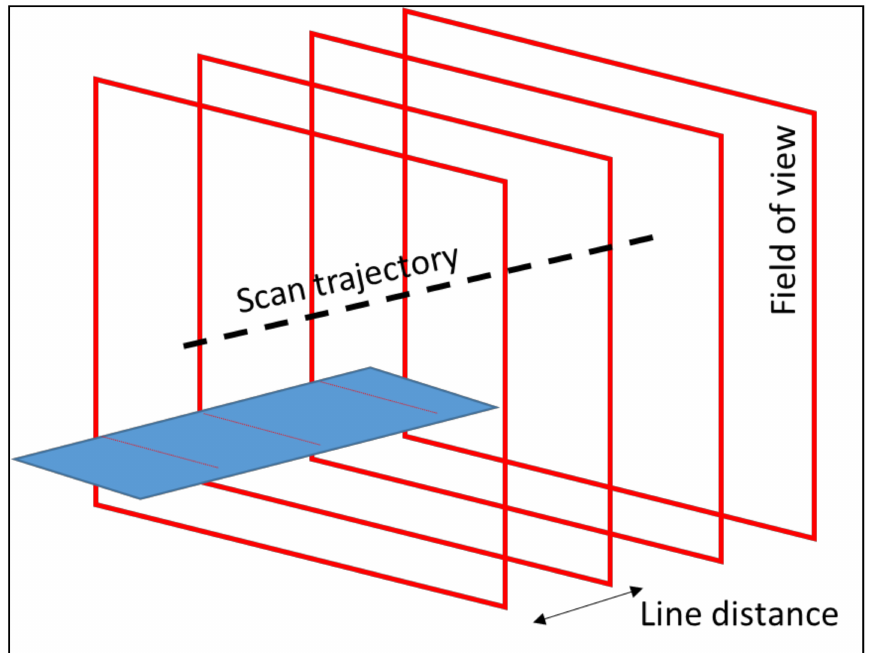
Figure 12. Point cloud generation of a surface (blue) by multiple fields of view.